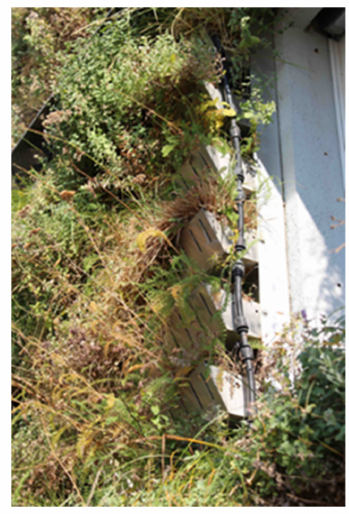
Figure 4. Vertical soaker hoses on the sides of the trough system.